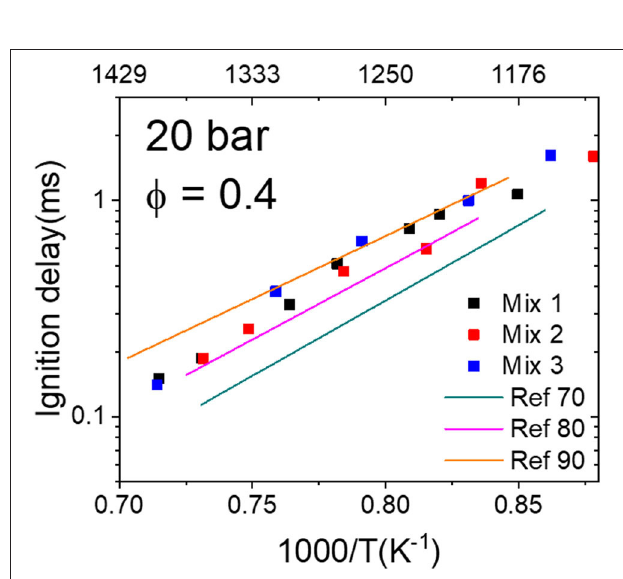
FIGURE 6 | Comparison of the ignition delay times (IDTs) of the liquefied natural gas (LNG)/liquefied biogas (LBG) mixtures to the reference mixtures measured in the high-pressure shock tube (HPST) at 20 bar, φ = 0.4. Points are Mix 1–3 (MN 80) and lines are reference mixtures Ref 70, 80, and